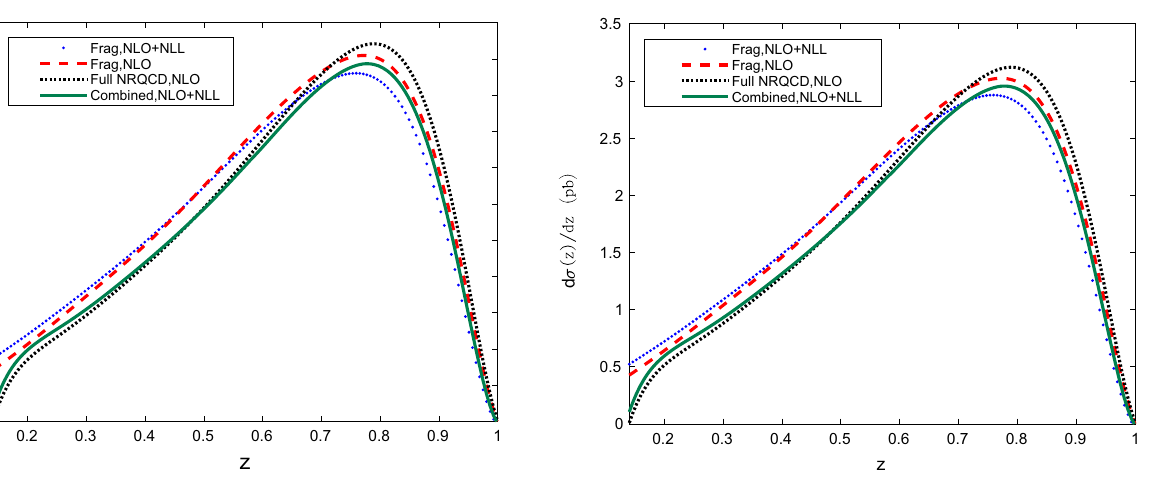
Fig. 5 The differential cross sections d σ/ dz for the production of the B c meson at the Z pole under different approaches